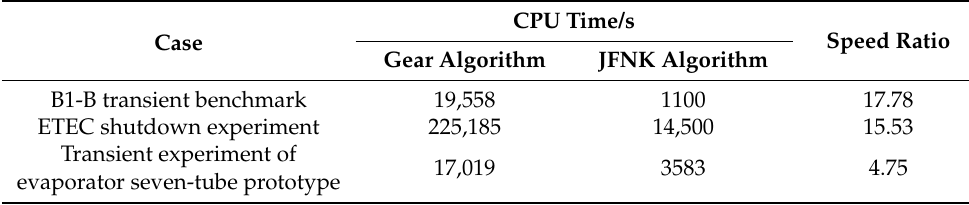
Table 3. Comparison of CPU time between the Gear algorithm and the JFNK